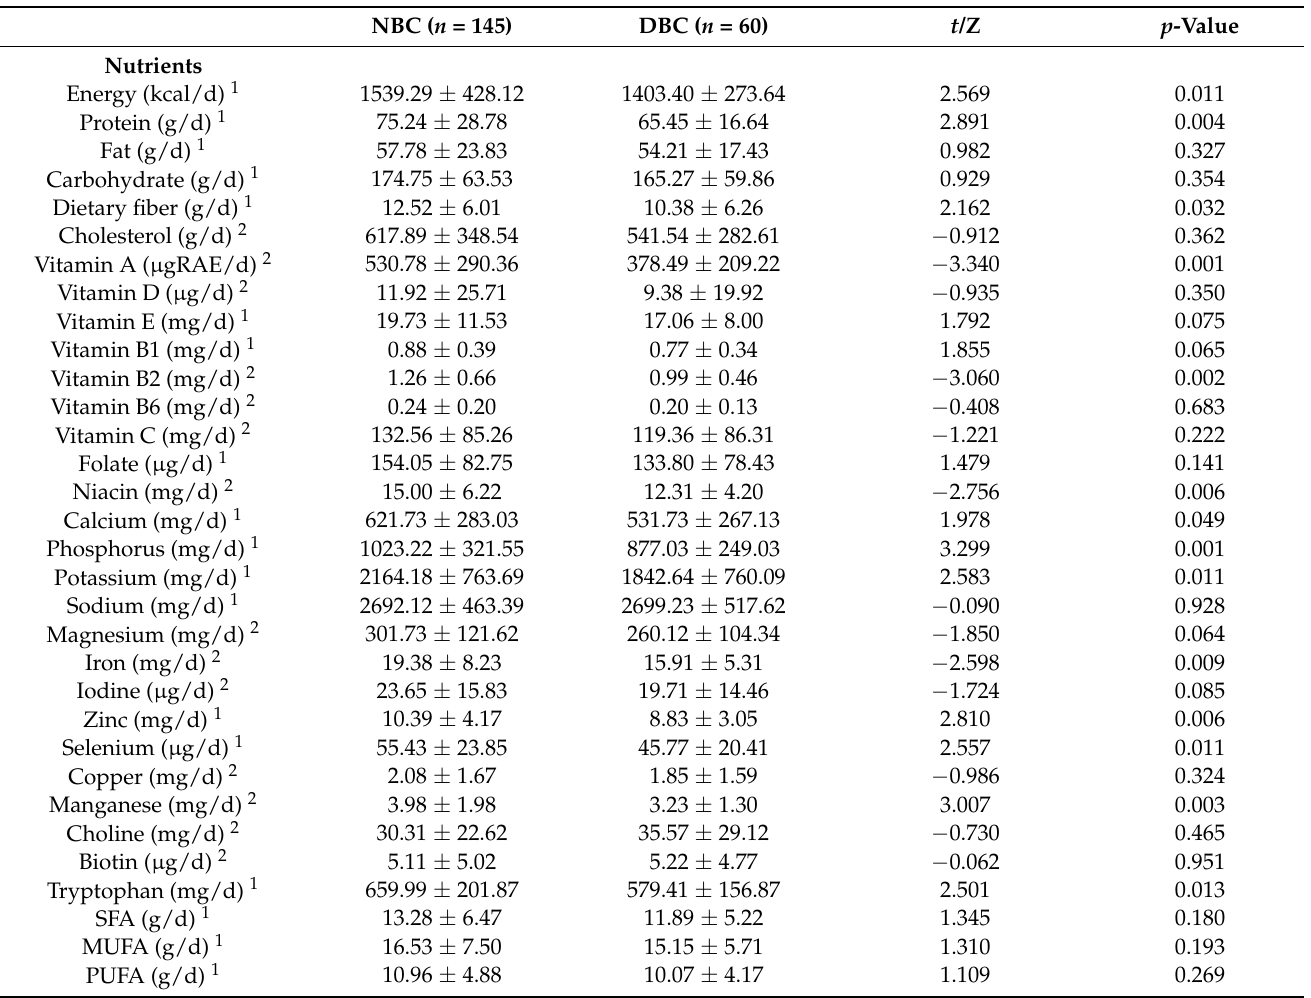
Table 1. Nutrient intakes and CHEI component scores of the depressed and non-depressed breast cancer